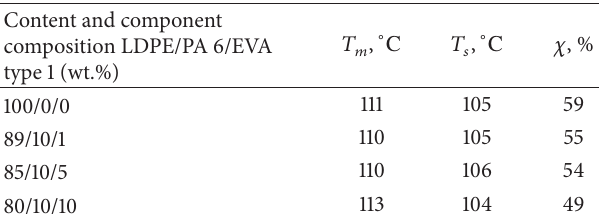
Table 2: Effect of the content of PA-6 and EVA-113 on melting point ( 𝑇 𝑚 ), softening point ( 𝑇 𝑠 ), and degree of crystallinity ( 𝜒 ) of pure LDPEanditscompositescontaining0.1 wt.%Agidol-40and0.1 wt.%